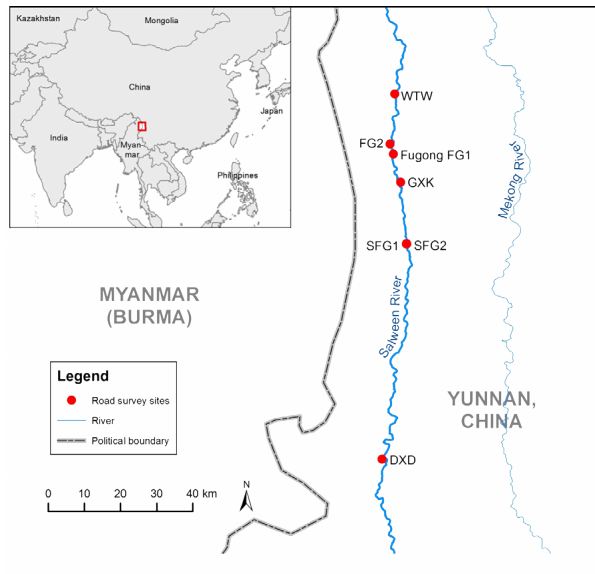
Figure 1. Map showing the general locations of the road survey seg- ments within the Salween River basin. Given the recent construction of these unpaved mountain roads, no road network map is available. The map in the upper left corner shows the general location of the study area within China and the greater Asian